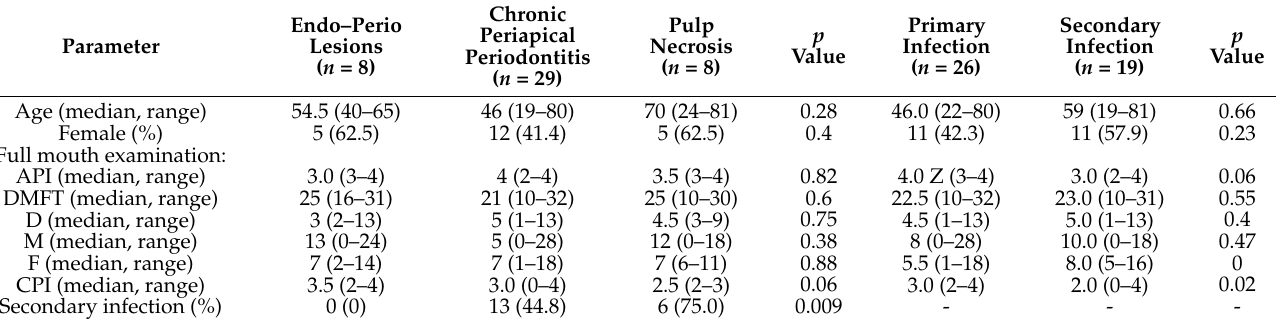
Table 1. Demographic and clinical characteristics of the study